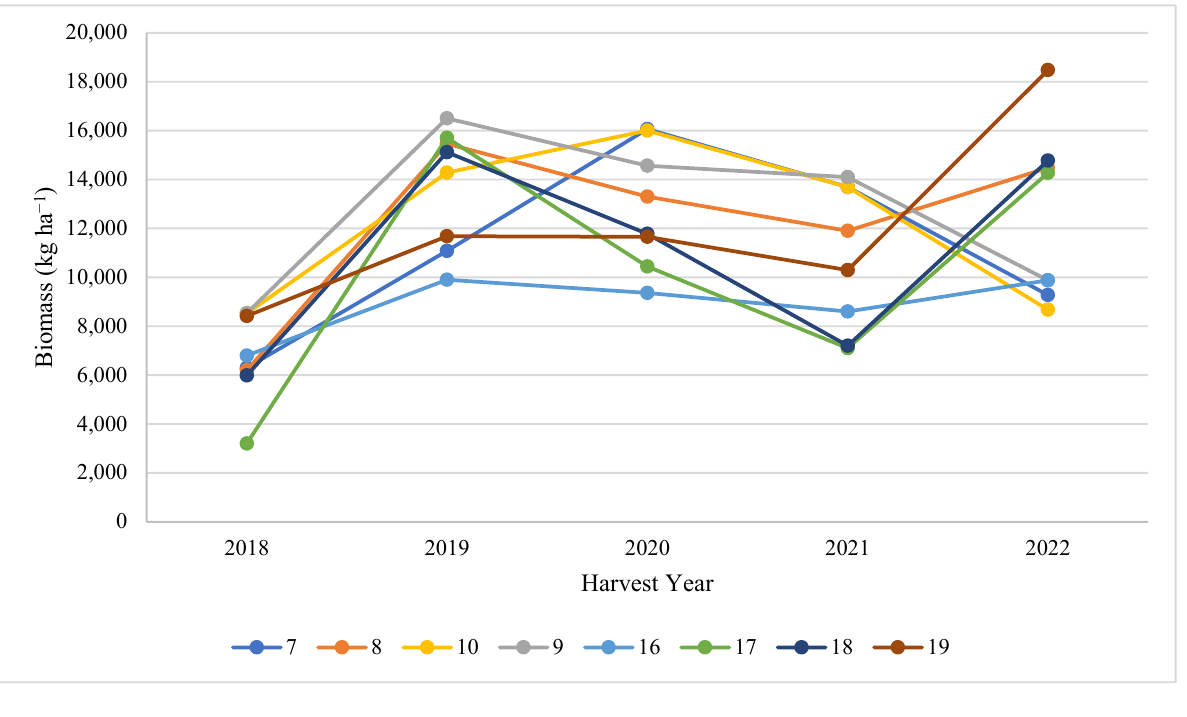
Figure 3. Yearly trends in total biomass yield (kg ha − 1 ) for the eight alfalfa zones from 2018 to 2022, with 2022 having different treatment levels. Table 5. Percent difference in biomass between years. Positive values indicate an increase in biomass from the previous